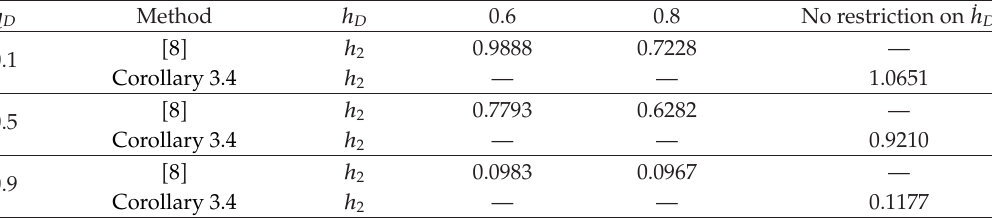
Table 1: Upper delay bound h 2 with h 1 (cid:9) 0.